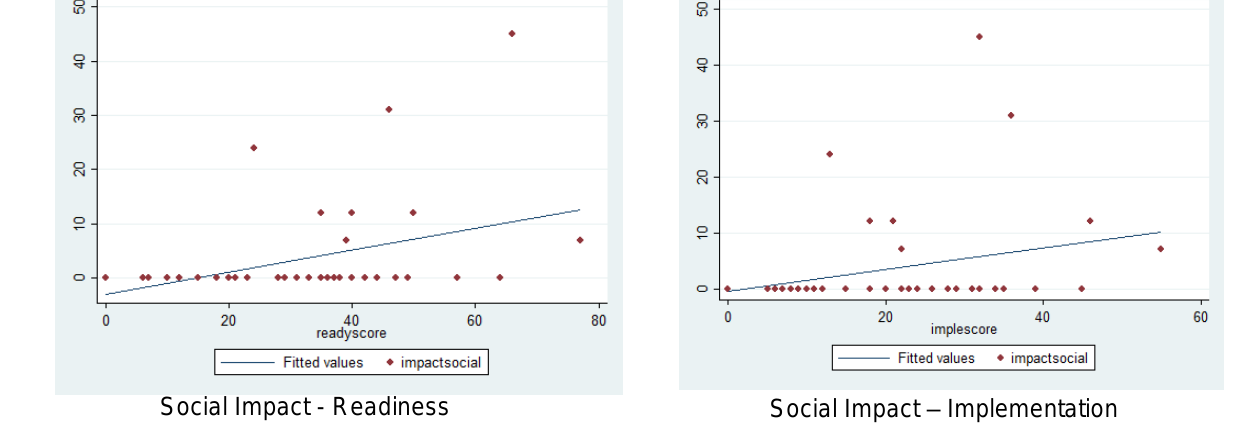
Figure 2. Two-Way Scatter Plots